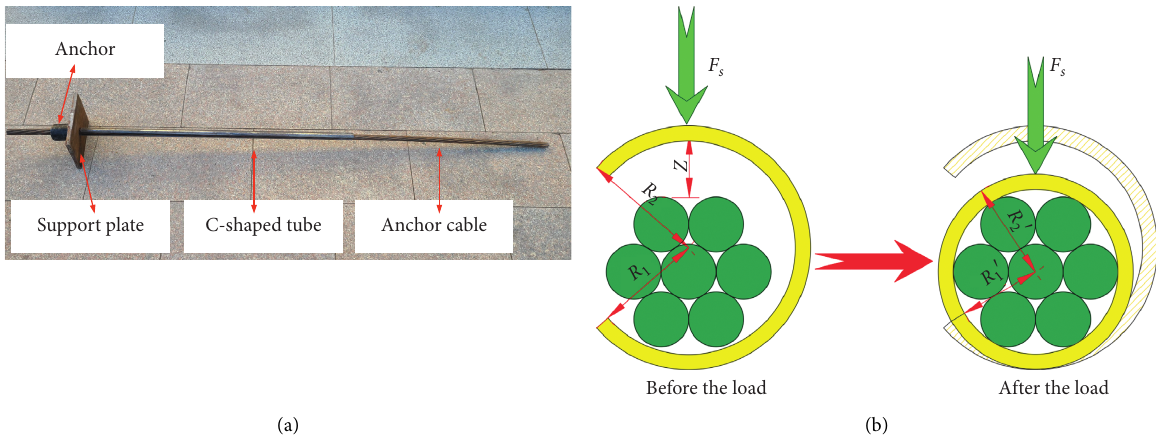
Figure 1: Physical drawing and schematic of ACC. (a) Physical drawing of the ACC. (b) Schematic diagram of action form of